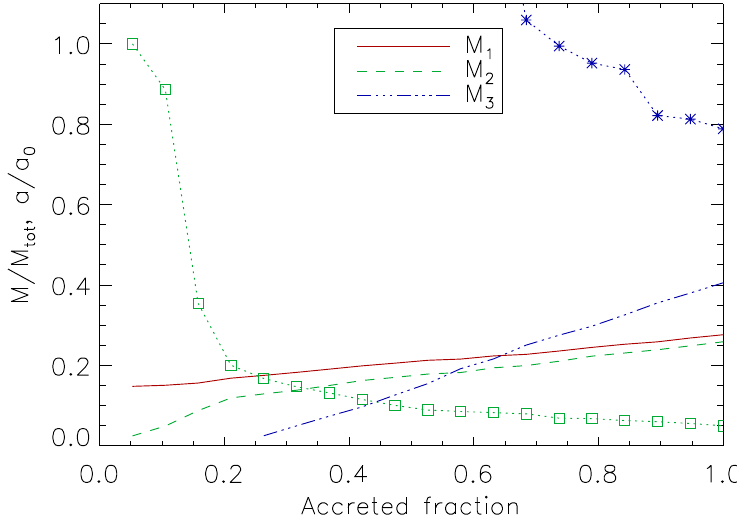
Figure 8. Formation of a triple system by sequential disk fragmentation and migration according to the model of Tokovinin and Moe [38]. The lines show the fraction of mass in each star vs. fraction of total accreted mass. The squares and asterisks show the inner and outer semimajor axes, respectively, in relative units. The first binary (green) forms early, at 0.05 accreted fraction, and migrates from 30 au to 0.05 au, reaching the final inner masses of 0.80 and 0.75 M (cid:12) (a twin). The tertiary component (blue) forms at 178 au separation (outside the plot limit) when 0.25 fraction of the mass was already accreted and migrates to 23 au, reaching the mass of 1.18 M (cid:12) and becoming the primary component of the triple. In most cases, however, the tertiary forms later and does not outgrow the inner two